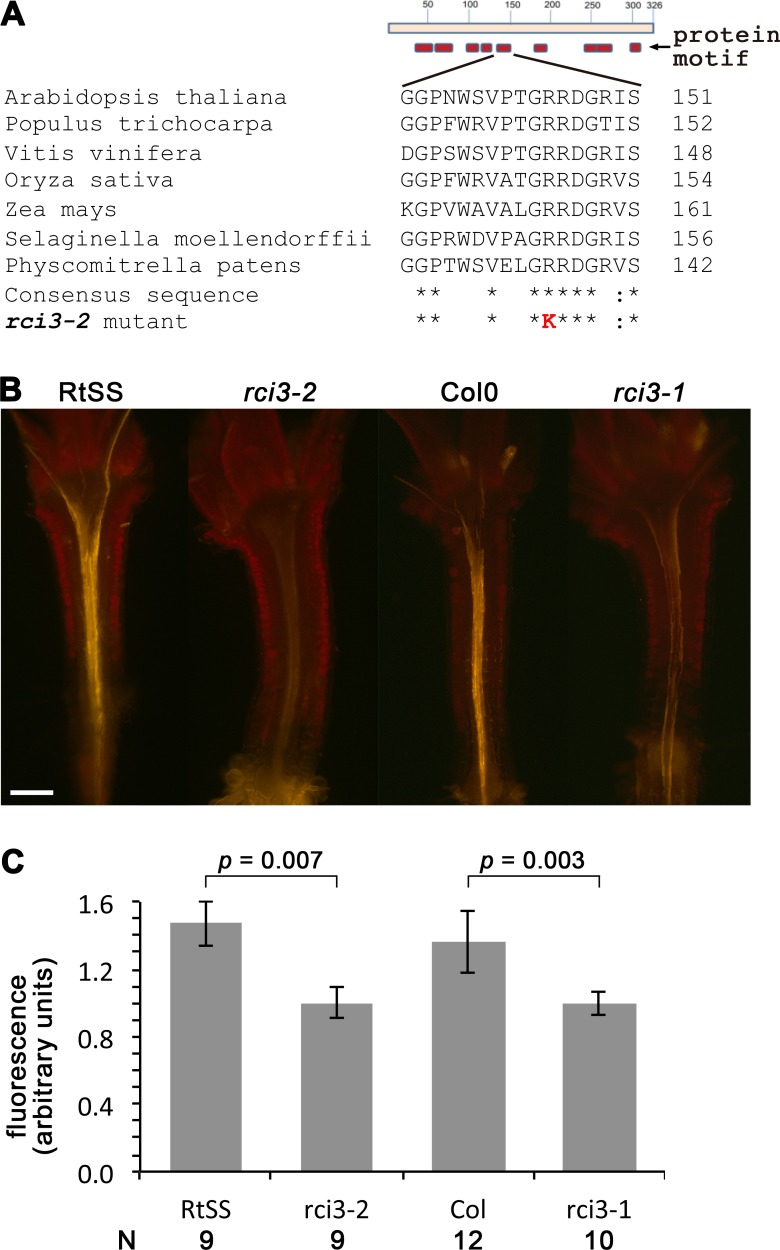
Mutation in RCI3/AtPrx03 reduces peroxide in rci3-2.(A) Protein structure and conserved motifs. Red boxes indicate the conserved motifs in plant type III peroxidases. rci3-2 has an R-to-K mutation in the GRRDG sequence within the fifth motif (number of conserved terminal serine residue in this motif indicated at right), which is conserved in all land plants. Stars indicate conserved amino acid residues. (B) Longitudinal median sections of wild-type 12-day-old RtSS and Col show strong orange fluorescence after staining with H2O2-specific indicator PO1, whereas rci3-2 and rci3-1 show weak fluorescence. Bar = 200 µM. (C) PO1 fluorescence was quantified; to account for any differences in background fluorescence from GFP, RtSS was normalised with respect to rci3-2, and Col0 was normalised with respect to rci3-1. Bars = 95% confidence intervals; P value from two-tailed unpaired Student’s t test. N, number of plants.